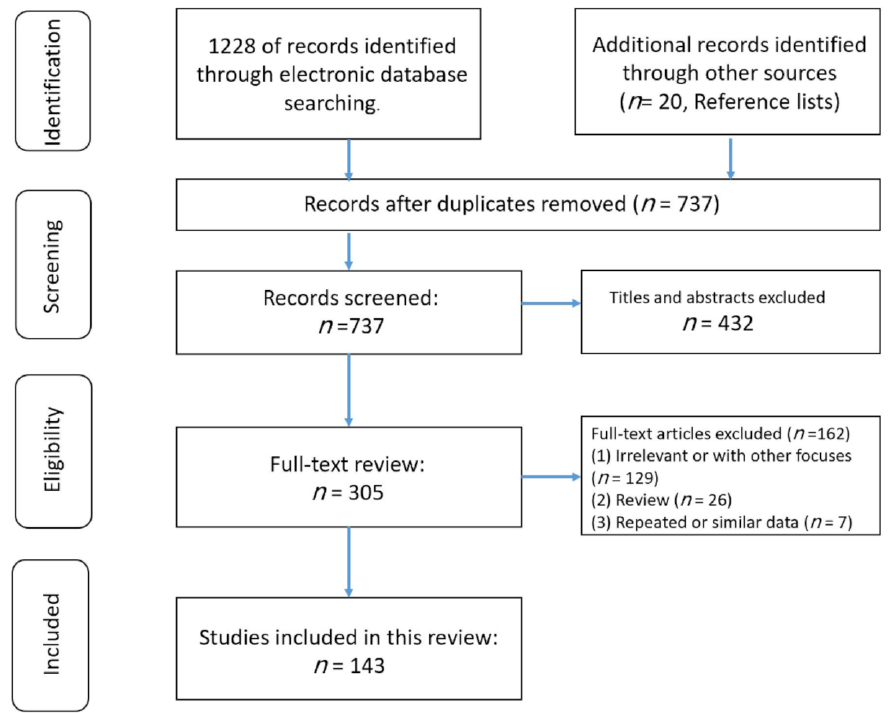
Figure 2. Timeline and major nodes of AI